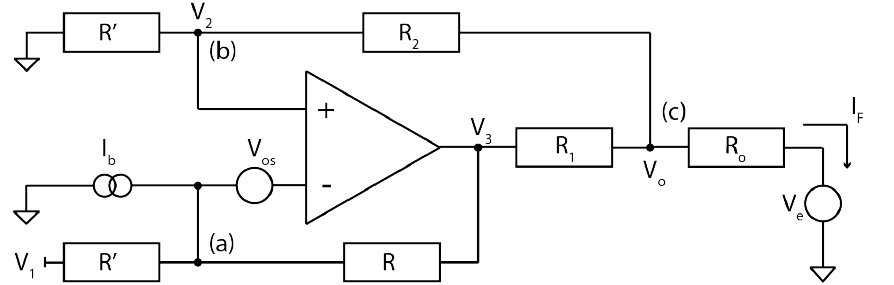
Figure A1. Idealised circuit for a transconductance